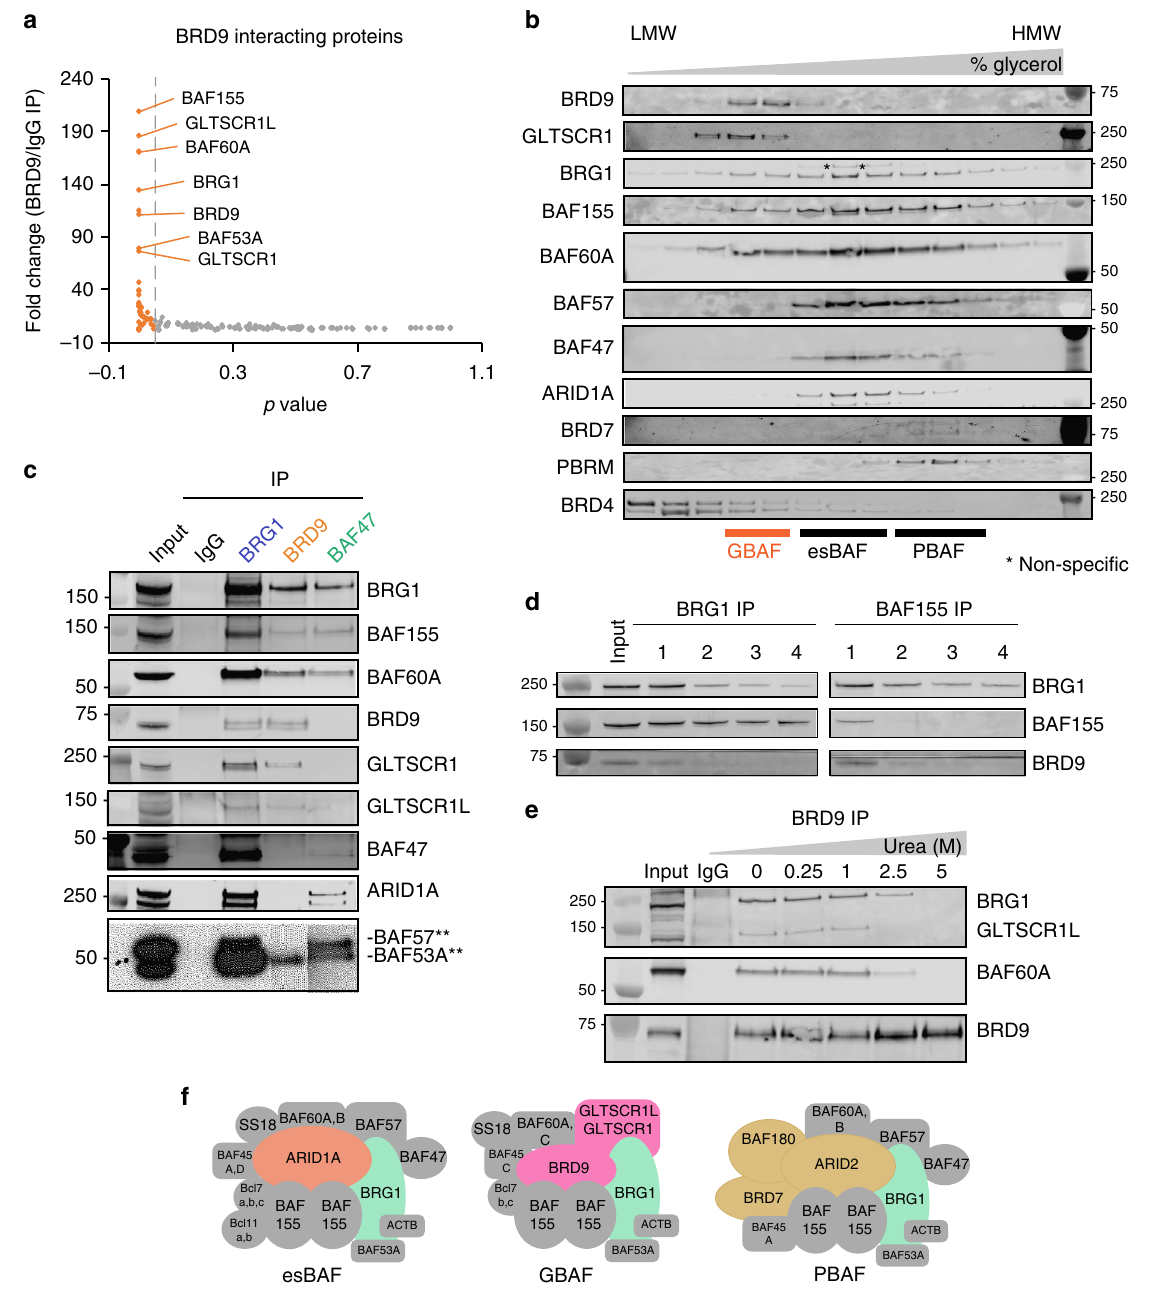
Fig. 2 BRD9 de fi nes a distinct, non-canonical BAF complex. a Immunoprecipitation (IP)-mass spectrometry using BRD9 or IgG antibody from mouse ESCs. The plot shows the spectral count fold change in BRD9 IP relative to IgG and the corresponding AC test p values, calculated with two technical replicates using PatternLab. In orange are proteins that satisfy FC 2, AC test p < 0.05. b Immunoblotting analysis of fractions after mouse ESC nuclear lysates were subjected to a density sedimentation assay in 10 – 30% glycerol gradient. LMW and HMW indicate lower and higher molecular weights, respectively. Nonspeci fi c bands are marked with an asterisk. Molecular weights from ladder are indicated. c Immunoprecipitation (IP) experiments from mouse ESC nuclear lysates using antibodies against BRG1, BRD9, and BAF47. Blots developed using chemiluminescence are marked with double asterisks; each IP was taken from a different exposure. d Depletion IP experiment from ESCs using antibodies against BRG1 or BAF155. Each lane shows the remaining proteins after each successive IP, labeled 1 through 4. e IP experiment from ESCs using antibodies against IgG or BRD9, which was incubated in increasing concentration of urea. f Schematic of the esBAF, GBAF, and PBAF complexes in mouse ESCs. Colored in orange, pink, and mustard yellow are subunits that de fi ne each individual complex. In green is the enzymatic component, BRG1. Source data are provided as a Source Data fi le GBAF complexes regulate naive pluripotency . Both KLF4 and observed downregulation of both Nanog and Klf4 in I-BRD9- Sp5 have been shown to regulate naive pluripotency in part treated ESCs (Fig. 5a). To determine if this downregulation was through the transcriptional regulation of Nanog , whose down- speci fi c to GBAF complexes, we performed RNA-Seq on Arid1a f/ f :CreERT2 ESCs treated with ethanol (vehicle) or tamoxifen to regulation marks the exit of ESCs from the naive state into a state induce deletion of Arid1a . In contrast to I-BRD9 treatment, that is primed for lineage speci fi cation 29 – 31 . Interestingly, we NATURE COMMUNICATIONS| (2018) 9:5139 |DOI: